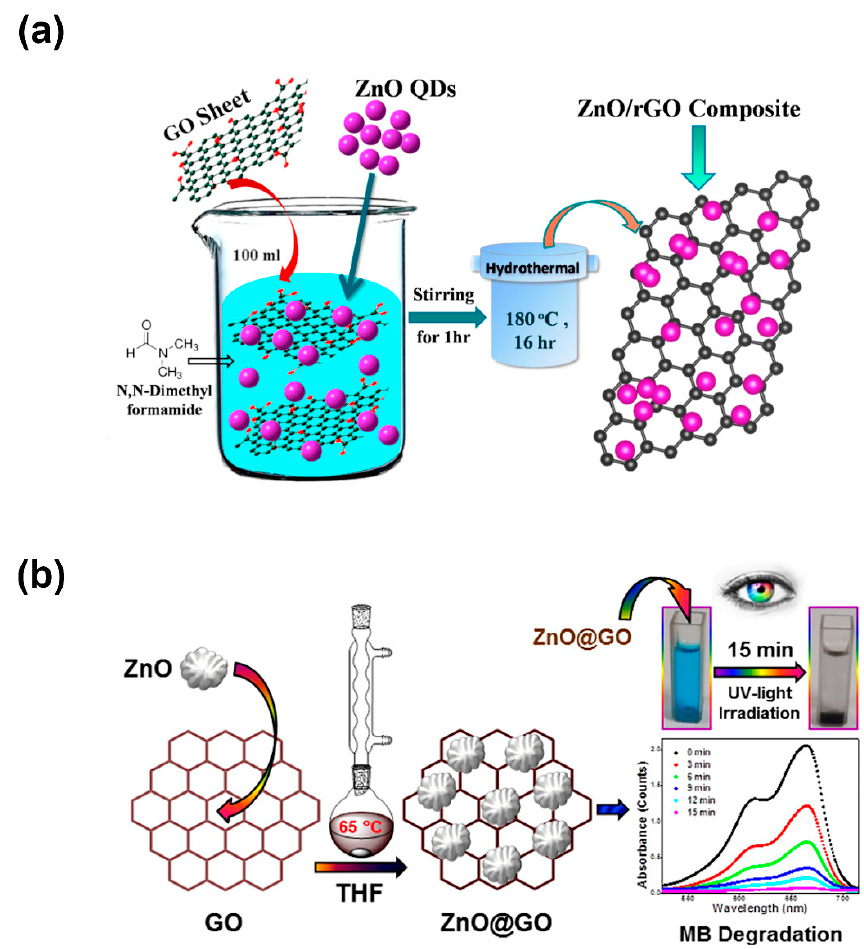
Figure4. Illustrationofthe( a )hydrothermaland( b )solvothermalsynthesisofZnO / GOnanocomposites; reproduced with permission from ref. [60] (with permission from Elsevier, 2016) and [56] (with Figure 4. Illustration of the ( a ) hydrothermal and ( b ) solvothermal synthesis of ZnO/GO permission from Springer, 2019), nanocomposites; reproduced with permission from ref. [60] (Copyright © 2016, Elsevier) and [56] (Copyright © 2019, Springer), respectively.